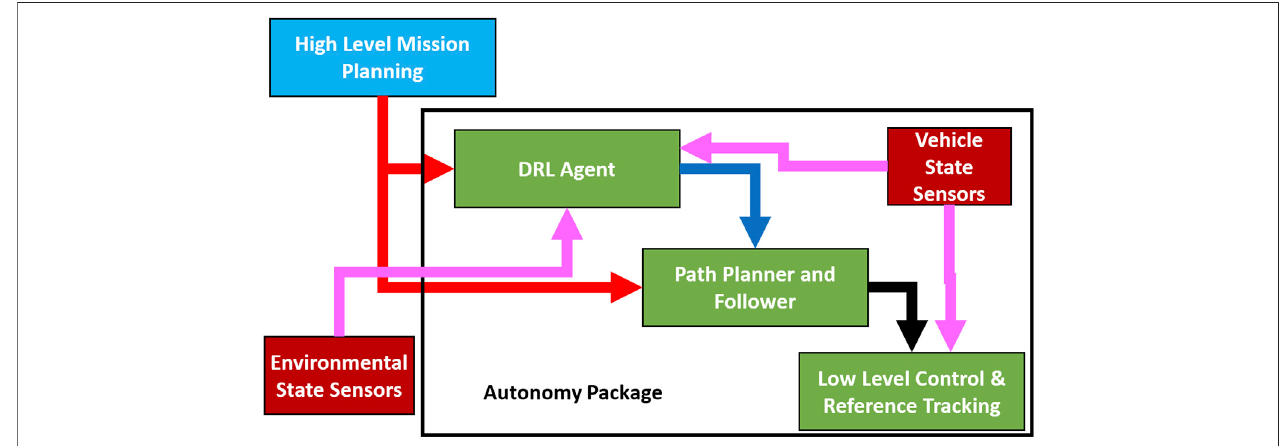
FIGURE2| IllustrationshowingmethodologyoftertiarycontrollersintegrationoftheDRLagentandlowerlevelcontrollers.Allprocessingcomponentsareshownin green, autonomy package items are within the black bounding box, mission waypoint fl ow is shown in red, fl ow of state information from sensors is shown in magenta, and DRL actions/predictionsareshowninblue. Referenceheadings areshown inblackand arebasedon theDRLaction when anactionisprovided and onthemission path when one is not.